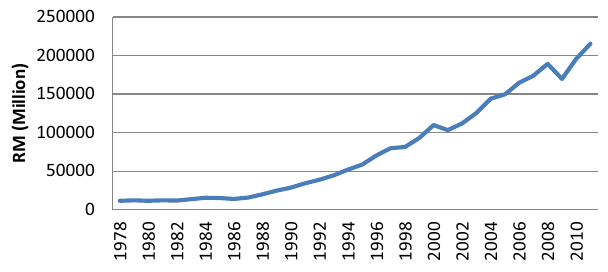
FIGURE 1 | Time series plots for each variable